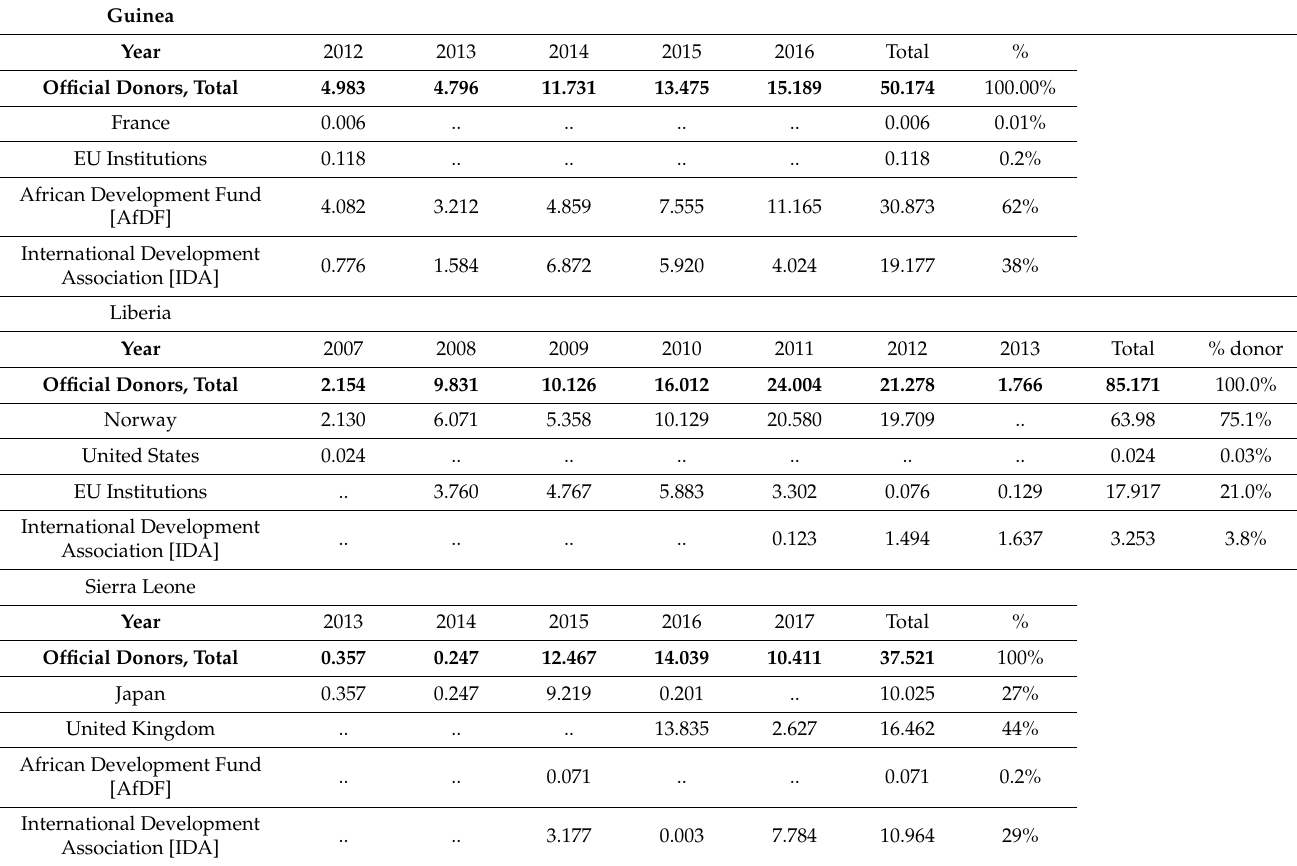
Table 7. ODA for electricity (millions